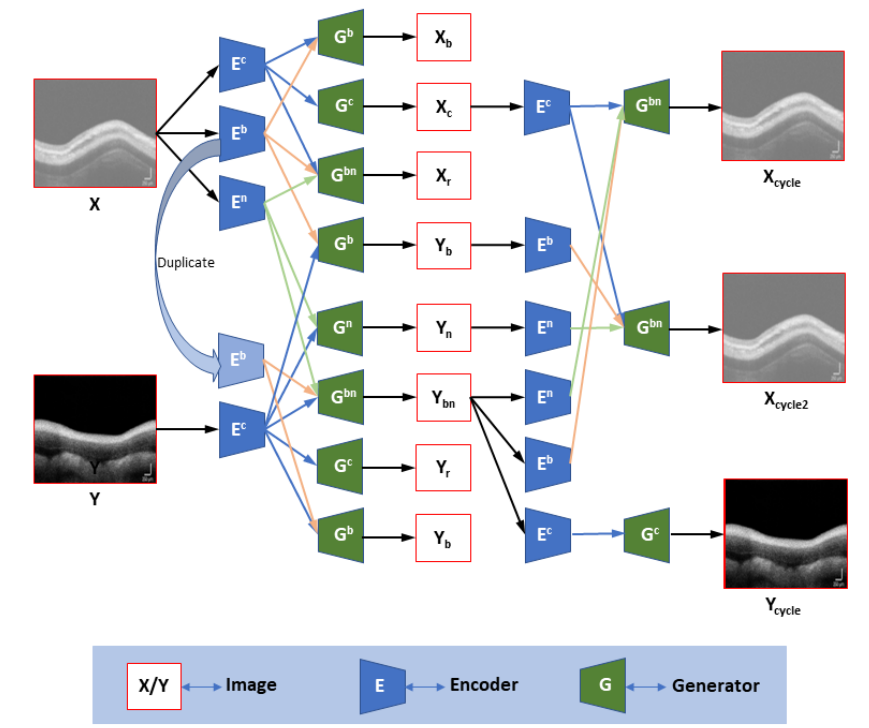
Figure 2. Framework of proposed image enhancement method. X and Y are inputs, where subscripts b, c, r, n, bn and cycle are blurred, clean, reconstructed, noisy, blurred and noisy, and cycled, respectively. The encoder and generator’s superscripts c, b, n, and bn is content, blur, noise, and blur-noise,